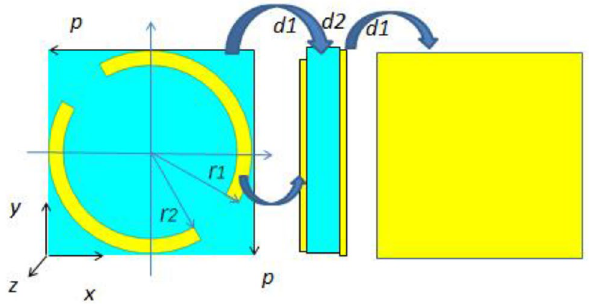
Fig. 1 Structural parameters of the polarization